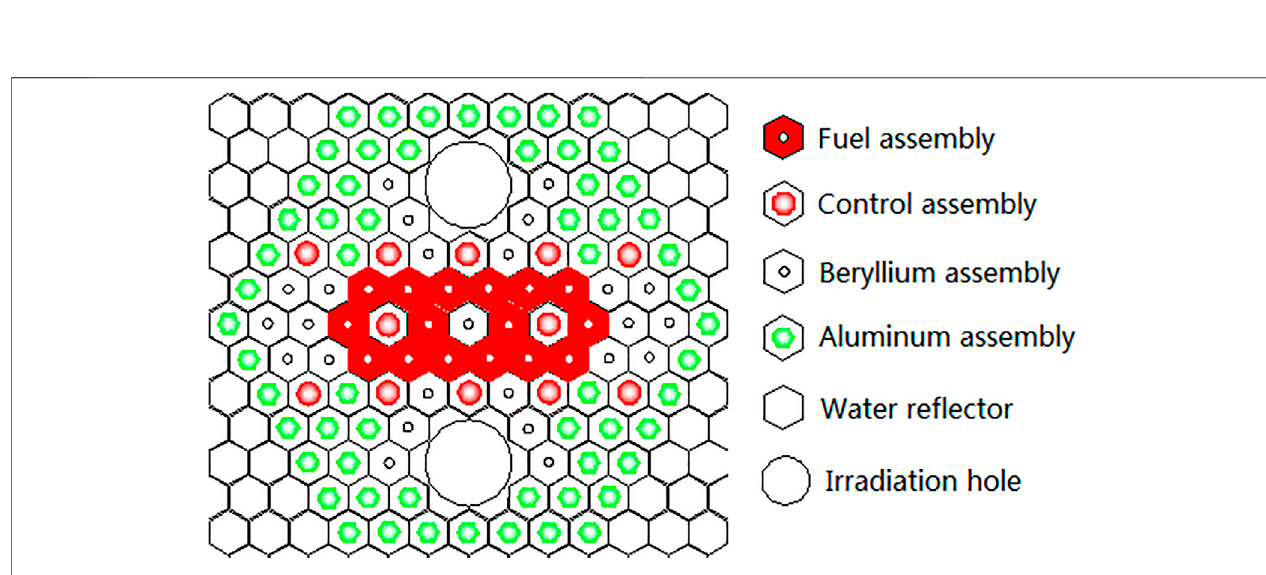
FIGURE 12 | Core arrangement of Scheme